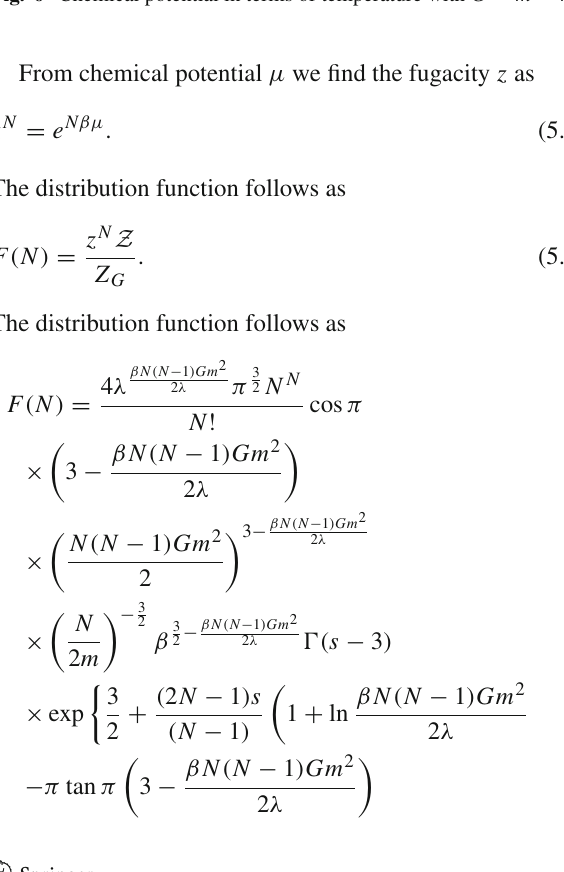
Fig. 6 Chemical potential in terms of temperature with G = m = k = 1, and λ = 1 / 6